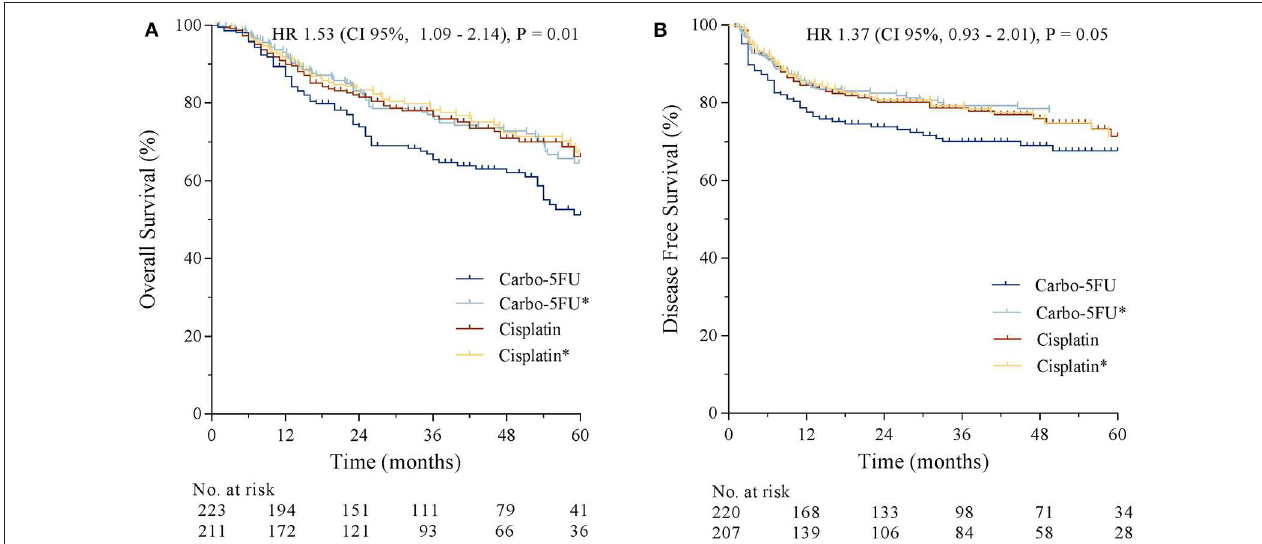
FIGURE 1 | (A) Overall survival stratified by chemotherapy regimen. (B) Disease-free survival stratified by chemotherapy regimen. The adjusted overall survival estimation for both cohorts is labeled with an asterisk.